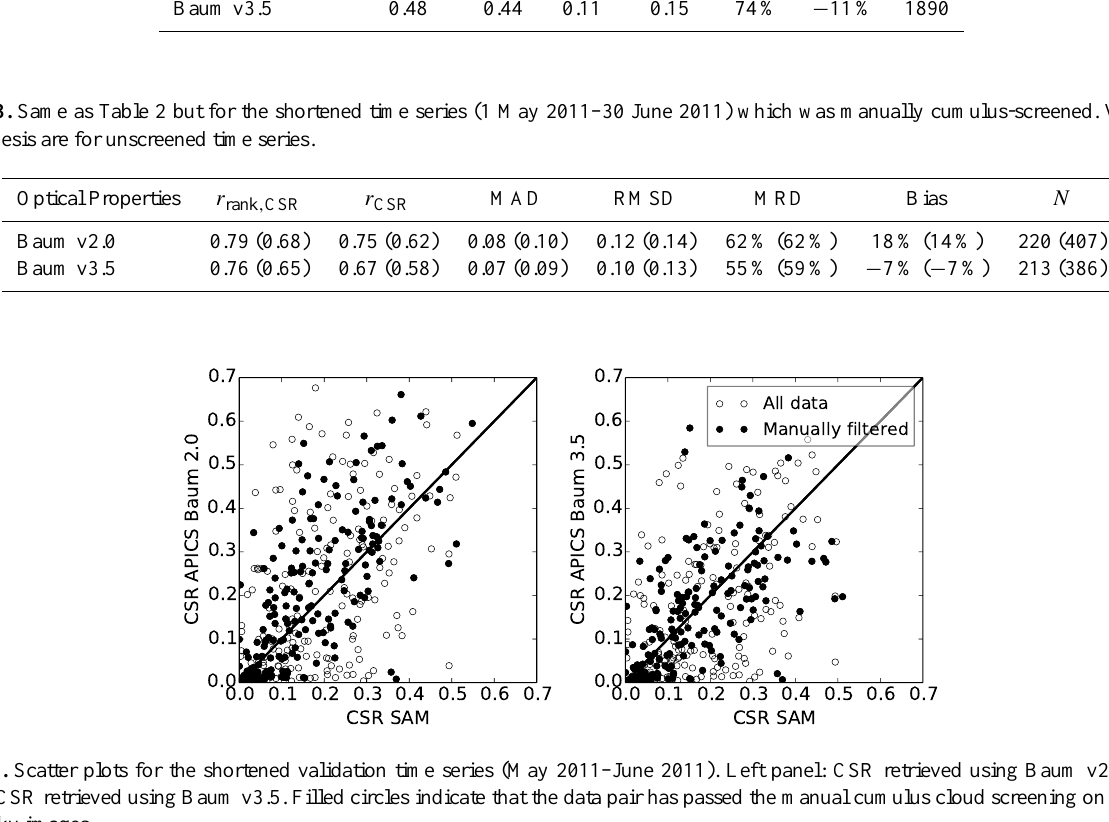
Fig. 11. Exemplary excerpt of the circumsolar ratio (CSR) time series used for the validation. In total 107 data pairs are shown. Grey symbols indicate that water clouds were identified in the manual screening of sky camera images. Time is given as UTC.